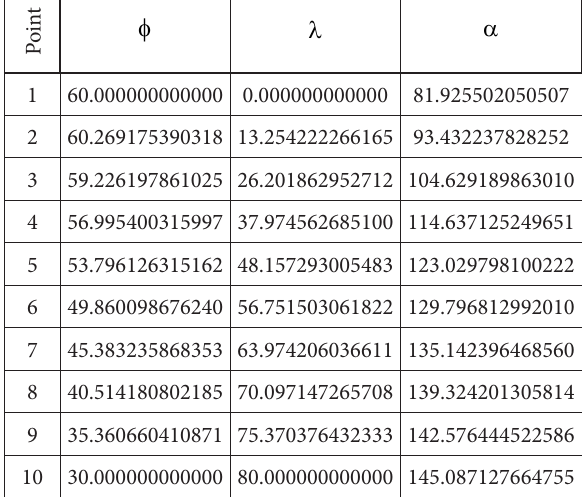
Table 5. Example of the path of the first normal section of case 8 (Table 2), GRS80